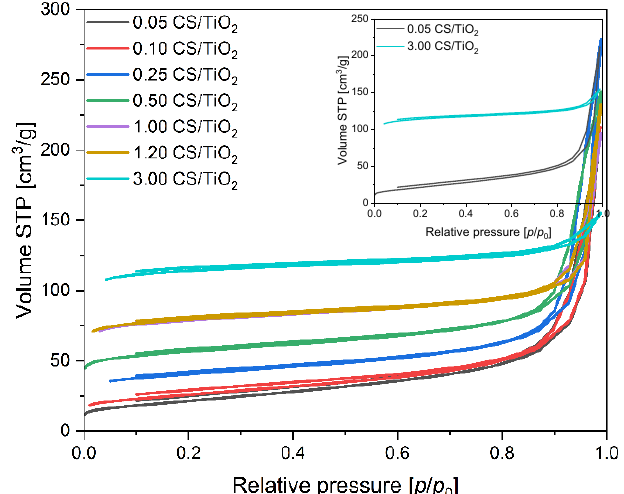
Figure 4. Nitrogen adsorption–desorption isotherms of all tested CS/TiO 2 composites, and selected 0.05 and 3.00 CS/TiO 2 samples (inset).